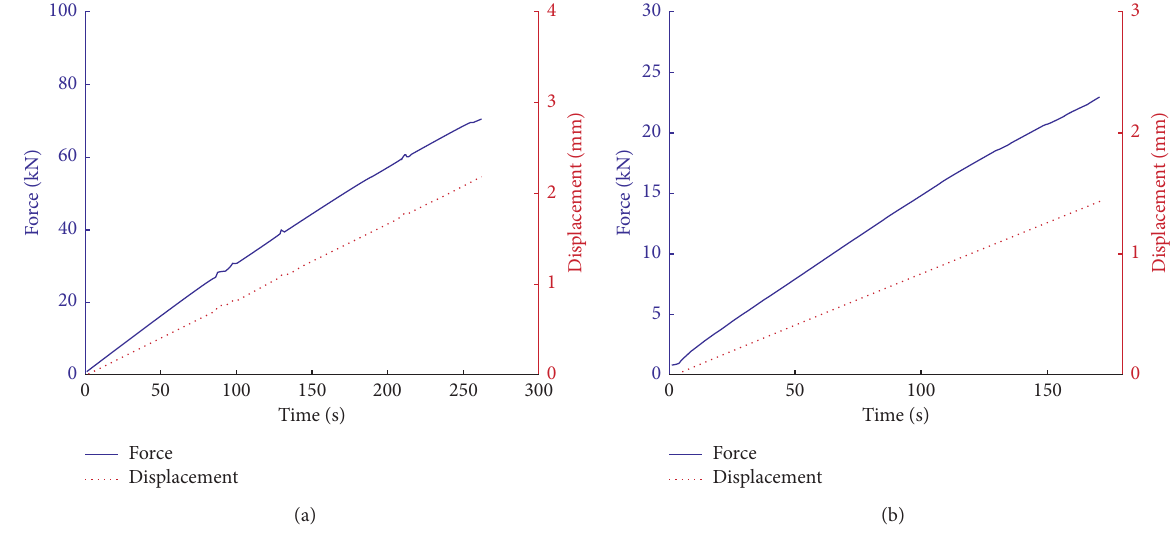
Figure 6: The time curves of maximum loading force and displacement. (a) [0/90/0/90/0